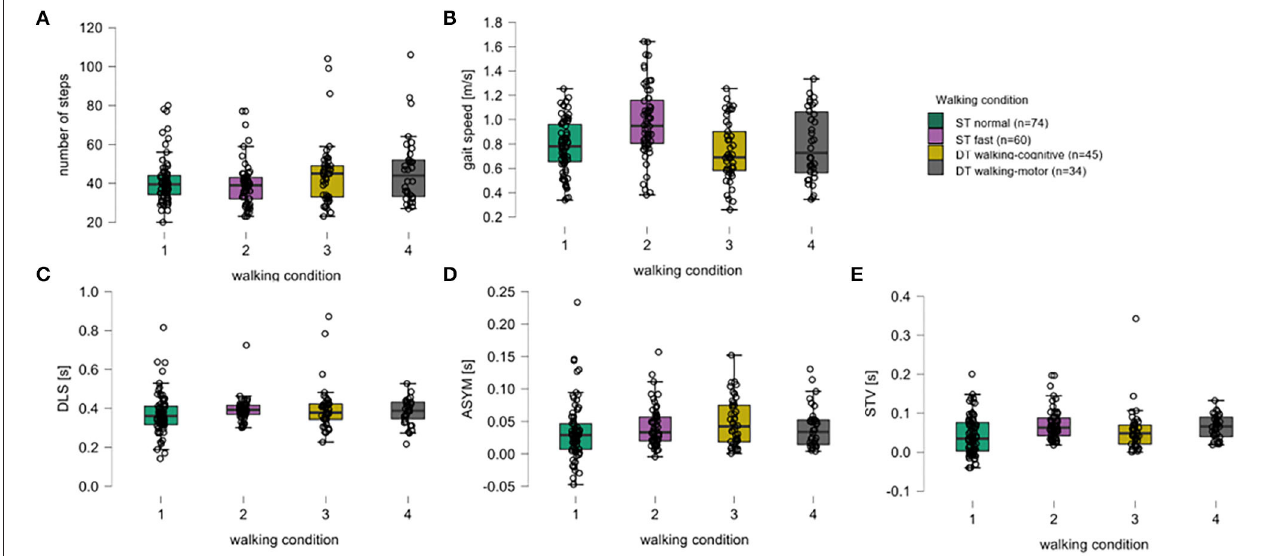
FIGURE 1 | Box plots for all walking parameters over all walking conditions. For the five walking parameters, (A) number of steps, (B) gait speed (meters per second), (C) double limb support (DLS, seconds), (D) asymmetry (ASYM, seconds), and (E) step time variability (STV, seconds), the medians (thick black horizontal lines), the interquartile range (IQR, black-bordered boxes), and lower and upper whiskers (values within ± 1.5xIQR), single-subject data points (black circles) are given for walking conditions of a single task normal pace (green, 1), a single task fast pace (violet, 2), the dual-task walking-cognitive (yellow, 3), and the dual-task walking-motor (gray,